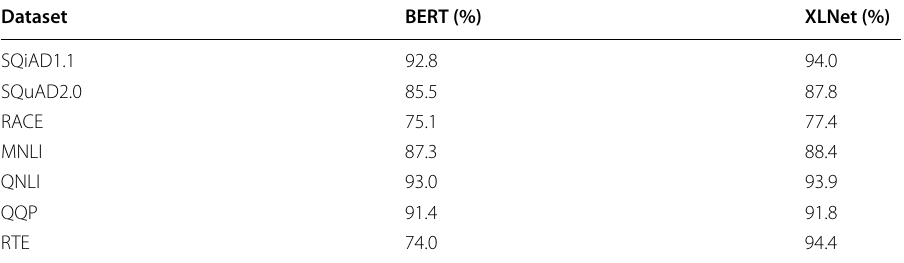
Table 3 Comparison between BERT and XLNet